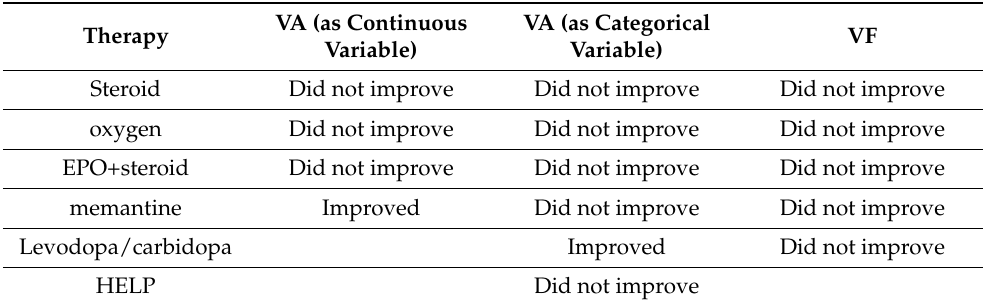
Figure 4. Comparison of interventions to no treatment regarding visual field. Table 2. Summary table of